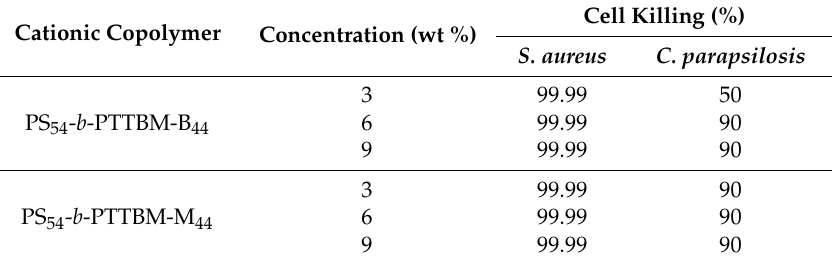
Table 2. Cell killing percentage of the breath figure films for S. aureus and C. parapsilosis microorganisms. Cationic Copolymer Concentration (wt %)